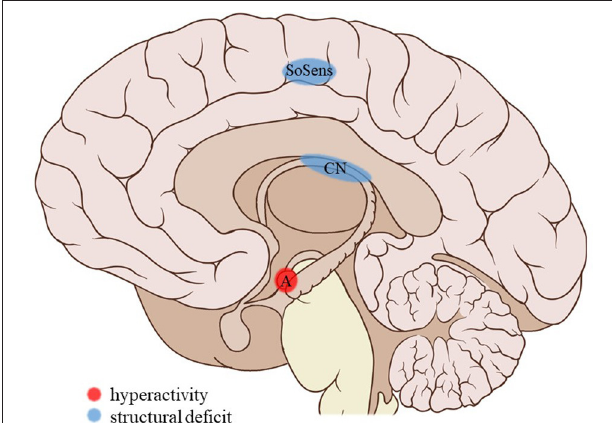
FIGURE 3 | Neuroimaging findings associated with SA. SoSens, genital somatosensory cortex; CN, caudate nucleus; A, amygdala. Adapted from: Patrick J. Lynch, medical illustrator; C. Carl Jaffe, MD, cardiologist. https://